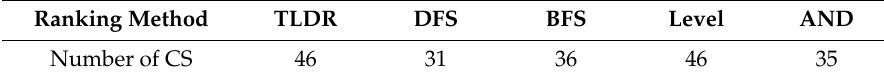
Table 1. Number of Cut-Sets